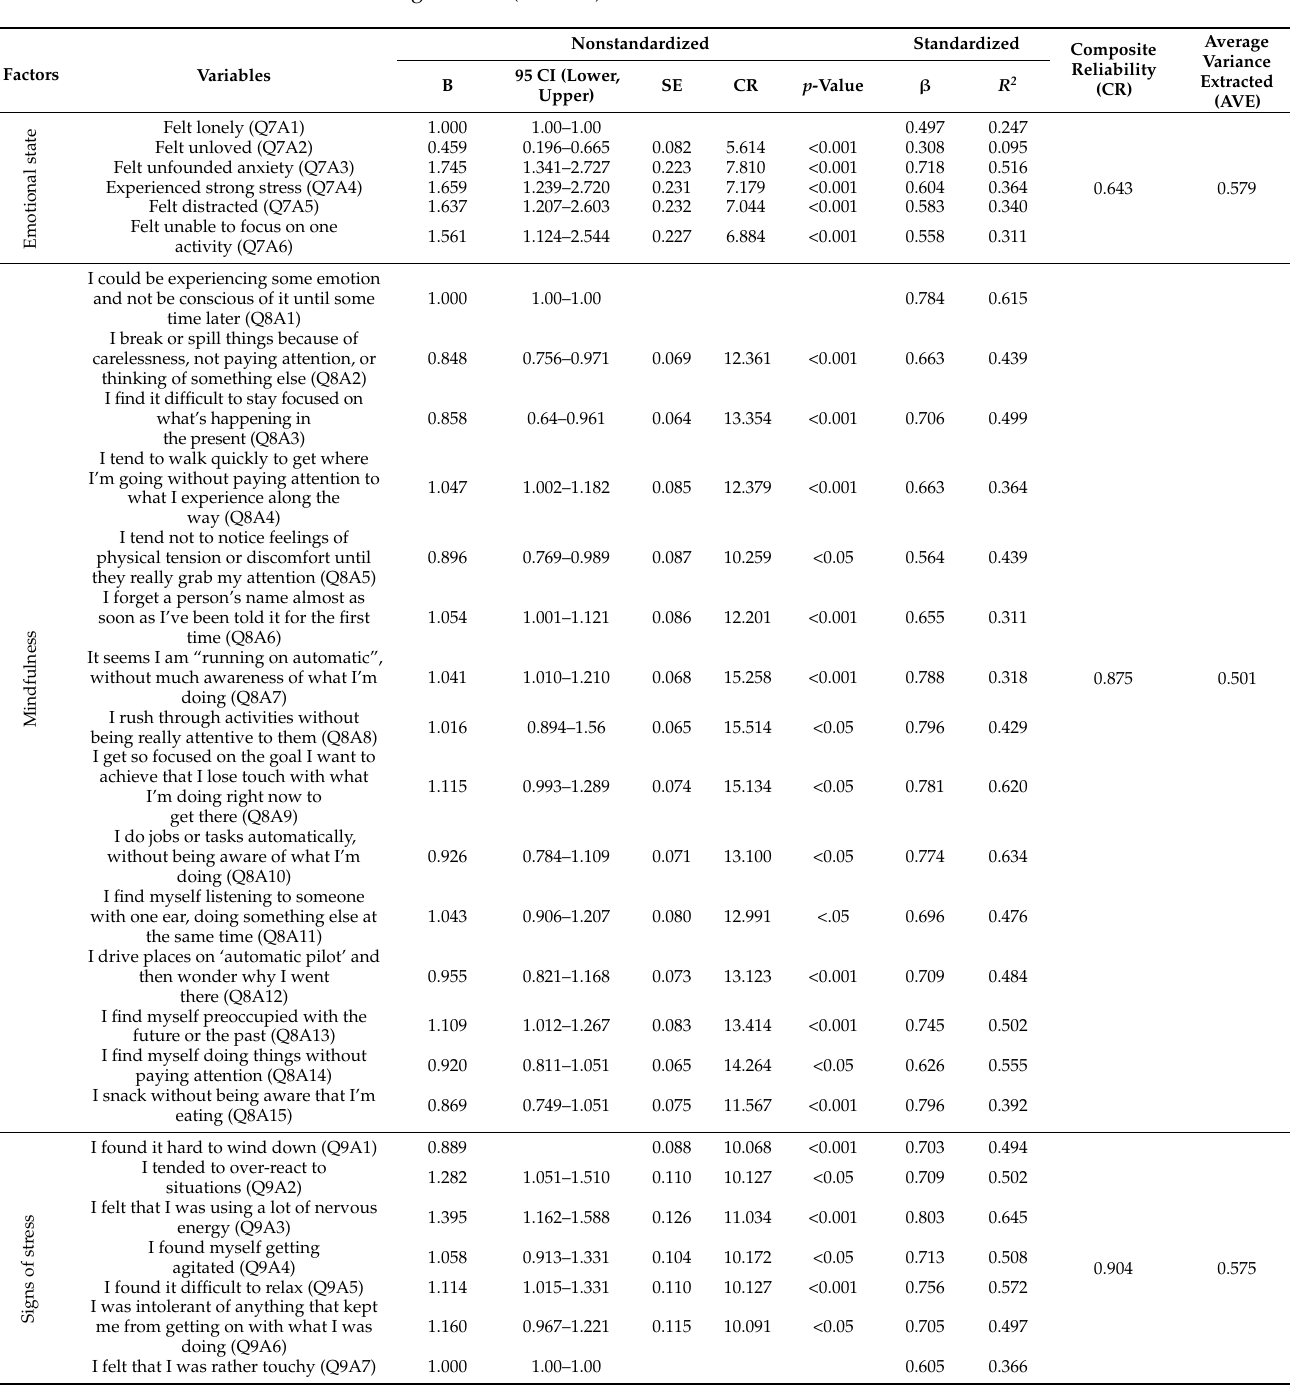
Table 3. Nonstandardized and standardized estimates for the analysis of observable variables in meditating athletes ( N =